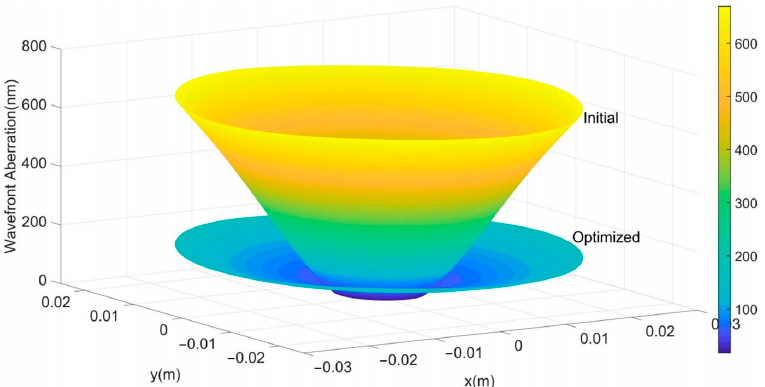
Figure 18. Wavefront aberration diagrams of the initial and optimized systems in the vertical optical